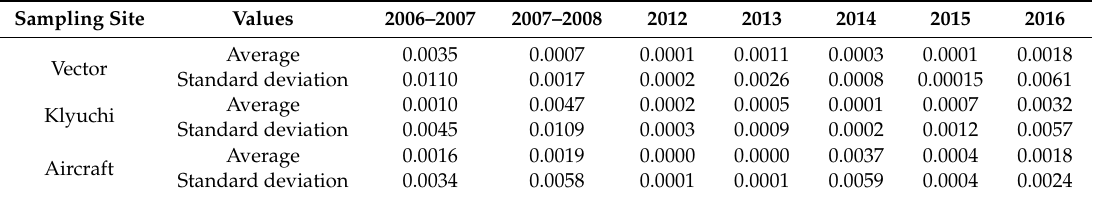
Table 4. The annual average values and standard deviations from them of the integral index of hazard of culturable bacteria and yeast in an atmospheric aerosol in the south of Western